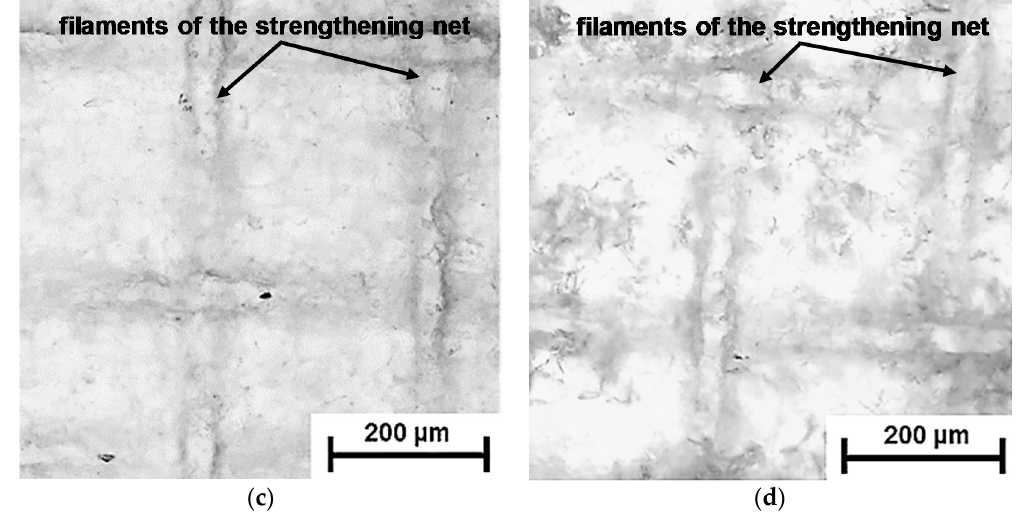
Figure 5. Optical images of the МА -41 membrane surface obtained using transmitted light mode in moments of time 10 s ( a ), 350 s ( b ), 720 s ( c ), and 900 s ( d ) after the beginning of contact of the swollen sample with the air.